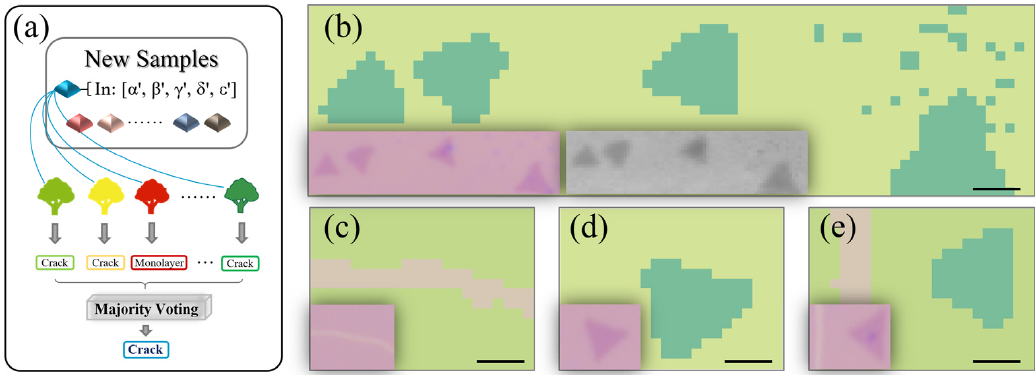
Figure 5. ( a ) Basic architecture of the prediction procedure in the random forest method. The new samples from the untrained data are judged through each tree one by one, and the final output results are acquired by the majority voting process. ( b – e ) The predicted pictures for different samples with crack (grown), monolayer (grass green) and bilayer (dark green) areas. The dispersed dots shown in Figure 5b are predicted to be bilayer. The inset figures in Figure 5b show the corresponding optical micrograph (left inset) and Raman mapping of the input variable ε (right inset). The other inset figures show the corresponding optical micrographs. Scale bars indicate 1 μ m.